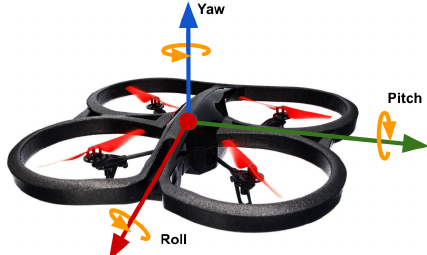
Figure 2. Quadcopter body frame: φ is the rotation on the X-axis, θ is the rotation on the Y-axis, and ψ is the rotation on the